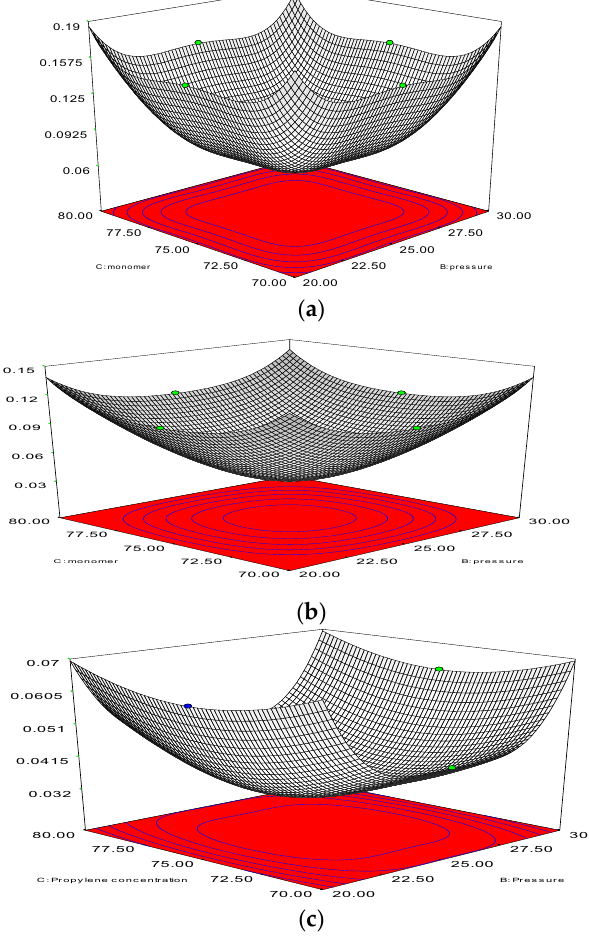
Figure 6. ( a ) Changes of polymerisation rate at node number 101,343 at various pressure and amount of monomer (propylene). y -Axis indicates the polymerisation changes; ( b ) Changes of polymerisation rate at node number 101,343 at various pressure and amount of monomer (propylene). y -Axis indicates the polymerisation changes; ( c ) Changes of polymerisation rate at node number 87,009, at various pressure and amount of monomer (propylene). y -Axis indicates the polymerisation changes.